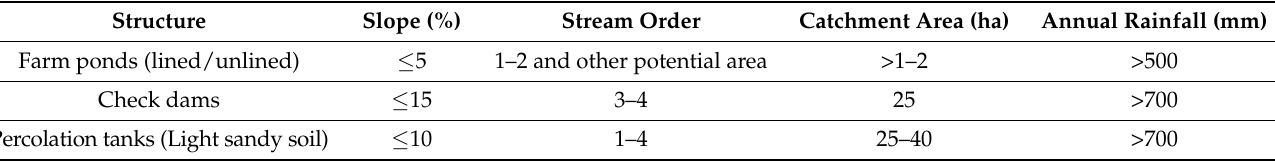
Table 2. Site selection criteria for the planning of water-harvesting/groundwater recharge